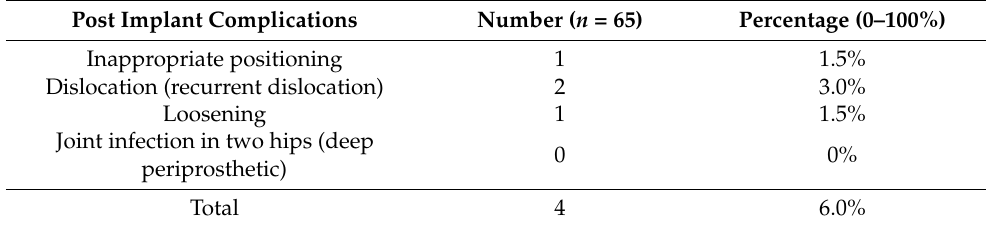
Table 4. Comparison of functional aspects by the pre-surgical—baseline (GPO) and two-year post- operative Harris Hip Score (HHS) domains of total hip arthroplasty (THA) in older people with unilateral osteoarthritis.